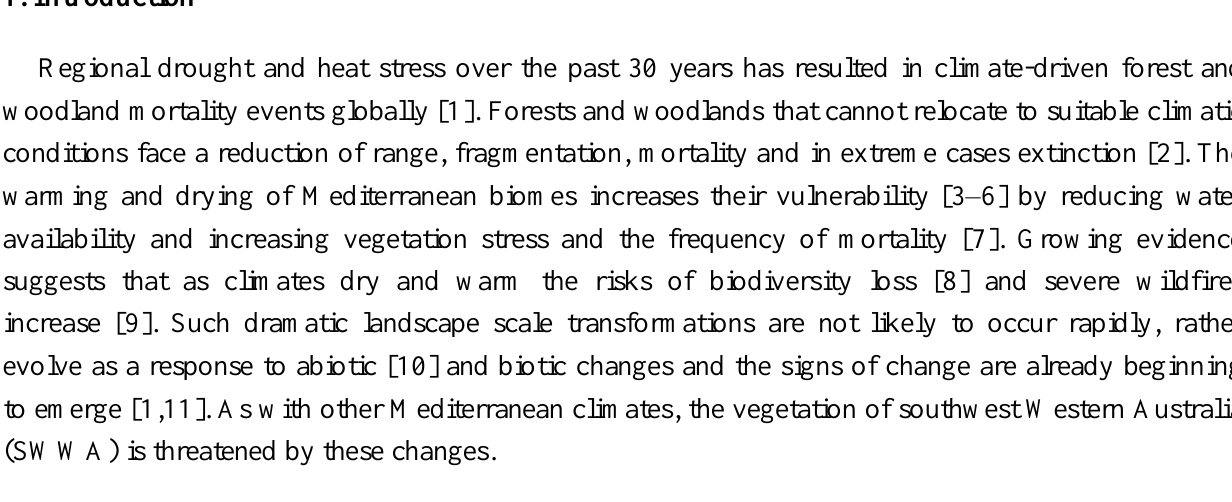
Figure 1. Map featuring the study area and the Interim Biogeographical Region of Australia’s NJF and SCP surrounding